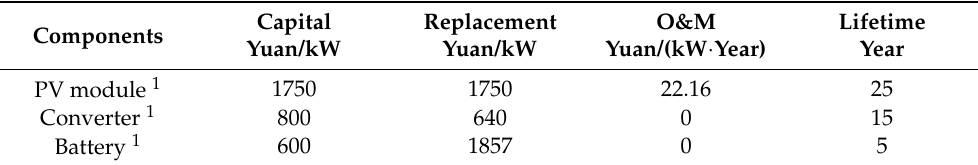
Table 6. Economic cost and technical characteristics of each component cost of PV